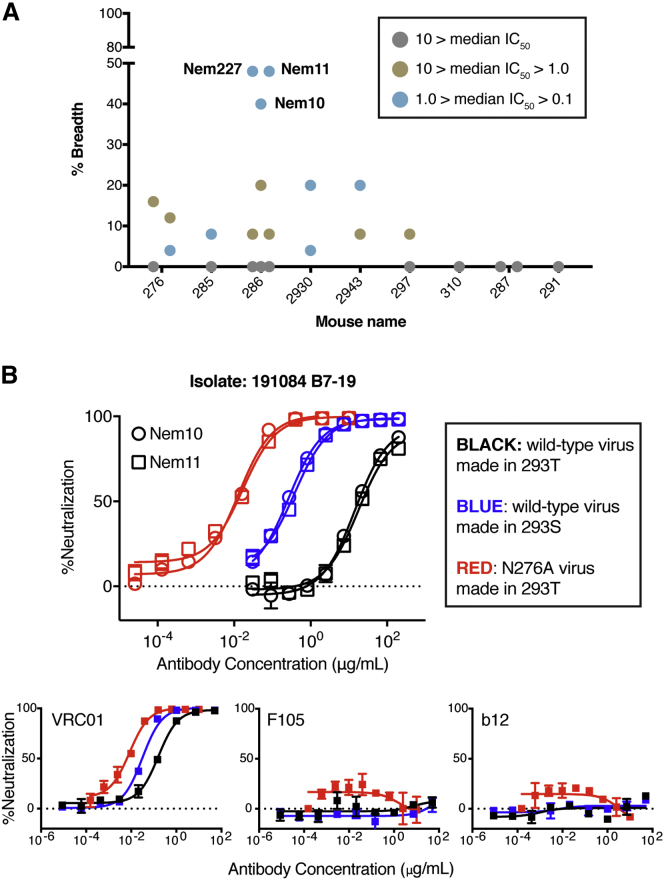
Neutralization by mAbs from Immunized Mice(A) Neutralization breadth and potency of mAbs isolated from several mice receiving the entire immunization program and screened on a 25-virus cross-clade panel of near-native (N276A) isolates.(B) Neutralization activity of two mAbs isolated from mouse 286. Nem10 (circles) and Nem11 (squares) neutralized wild-type 191084 B7-19 virus grown in 293T cells (black) or 293S cells (blue), as well as N276A virus grown in 293T cells (red), with potency highest against N276A virus. In the bottom three panels, neutralization curves for mature VRC01, F105, and b12 are shown for comparison. Neutralization values with error bars are mean ± SD for two measurements. Best fit curves were calculated with GraphPad Prism.See also Figure S6 and Table S4.